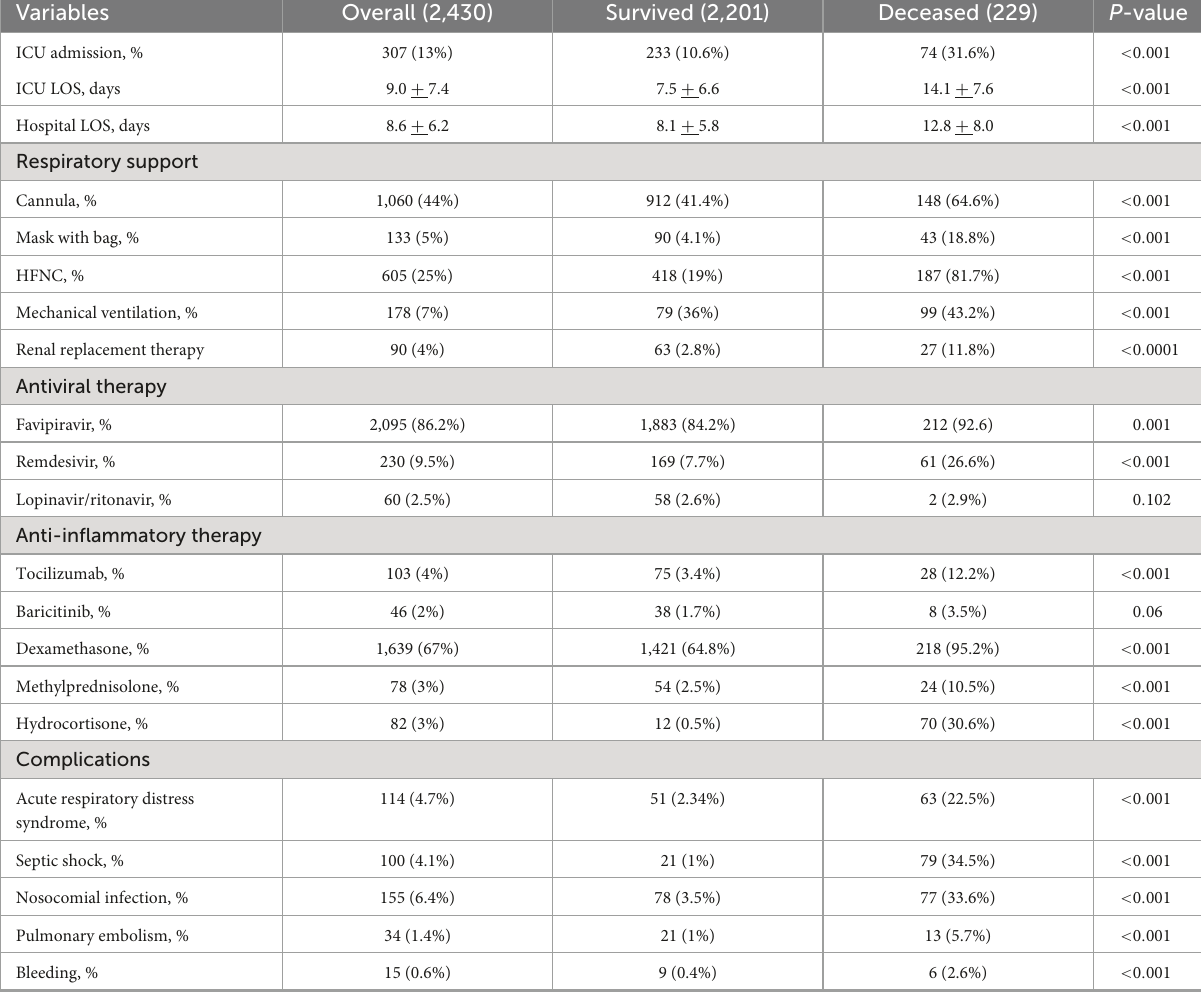
TABLE 3 Treatment and clinical outcomes of according to hospital mortality.